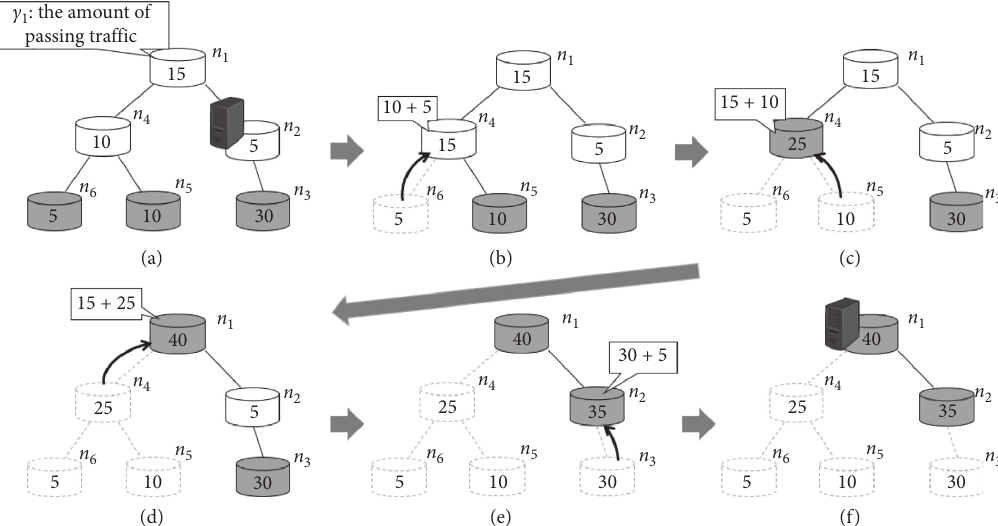
Figure 2: Single path virtual service resource replacement method of Horiuchi and Tachibana.